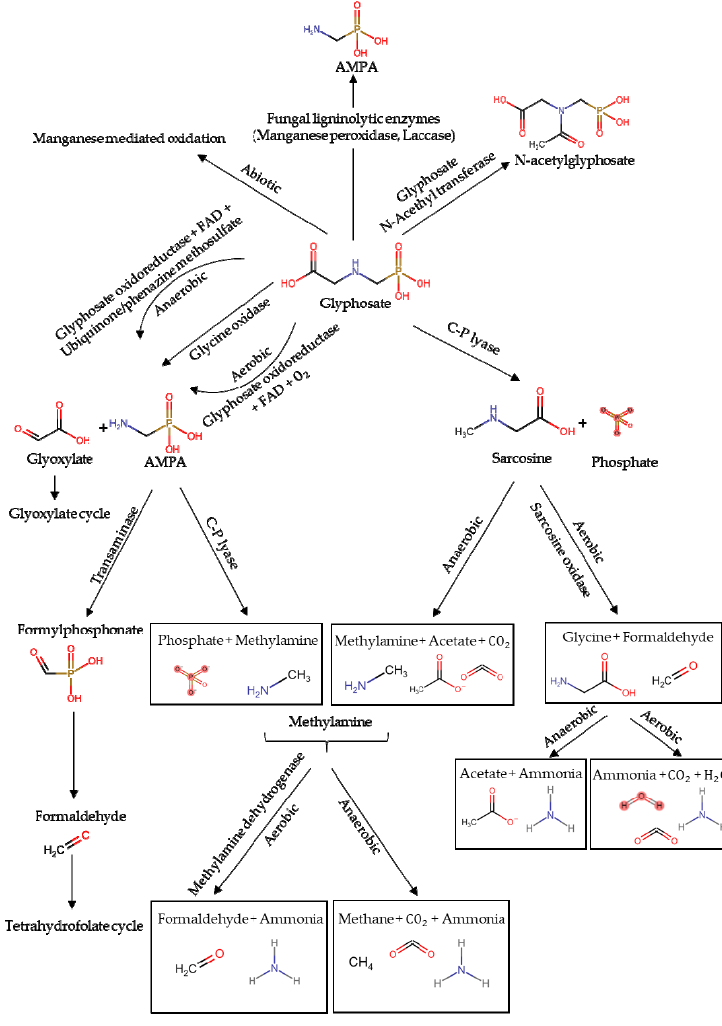
Figure 1. Main degradation pathways of glyphosate. Oxygen, water molecules and hydrogen atoms were omitted to facilitate the visualization.